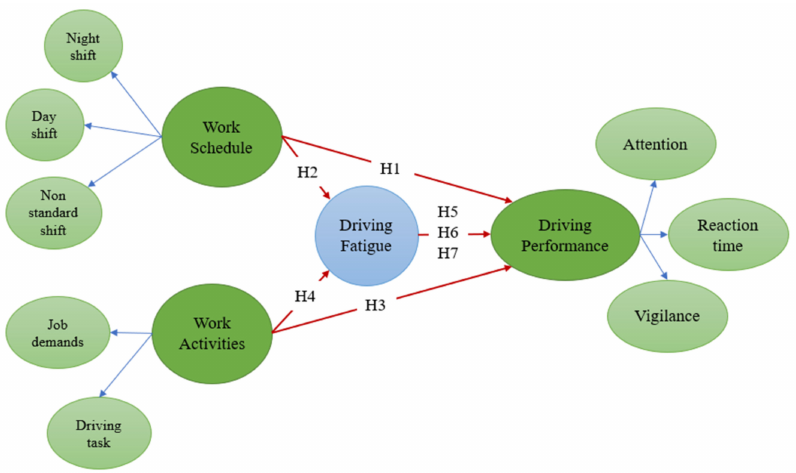
Figure 1. Driving performance hypothetical